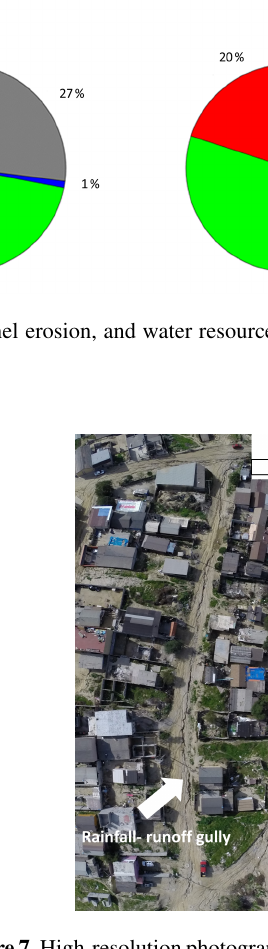
Figure 7. High-resolution photograph showing the contrast between gullies generated by rainfall–runoff only (road on left) and mega- gully B (road on right).